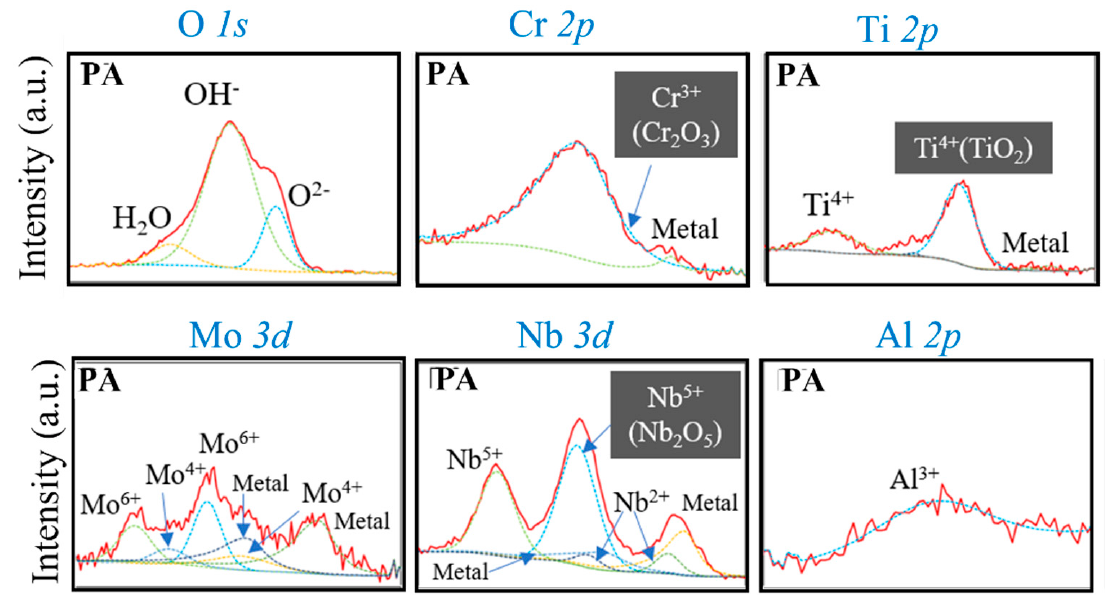
Figure 7. High-magnification XPS profiles of the Cr 2p, Ti 2p, Mo 3d, Nb 3d, Al 2p, and O 1s peaks of virgin Inconel 718 PA powder.